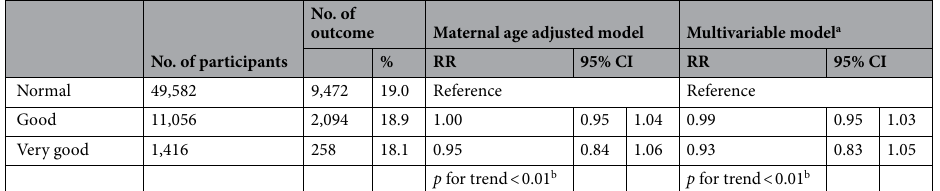
Table 5. Association between sleep during pregnancy and neonatal sleep in the Japan Environment and Children’s Study (2011–2014). CI, confidence interval; RR, relative risk. a Adjusted for maternal age at delivery, smoking habits, alcohol consumption, pre-pregnancy body mass index, gestational age at birth, parity, infertility treatment, infant sex, small for gestational age, type of delivery, and postpartum depressive symptoms. b Linear trend in the association was tested by assignment of ordinal variables for the five